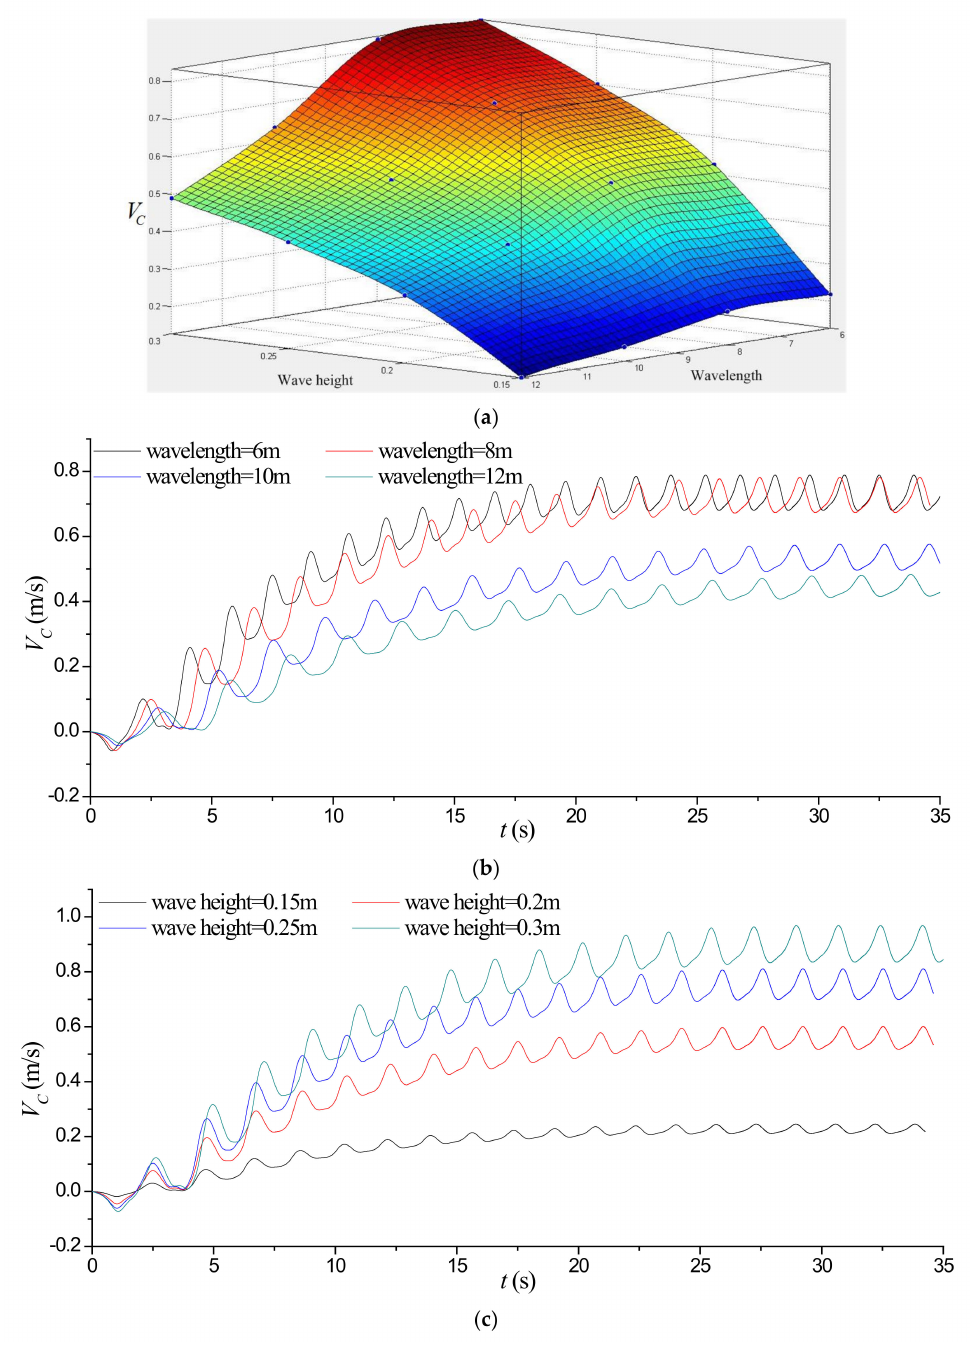
Figure 12. Under different wave parameters. ( a ) The curve of average values of V C under different wave parameters. ( b ) Variation curves of V C under different wavelengths when the wave height is 0.25 m. ( c ) Variation curves of V C under different wave heights when the wavelength is 8